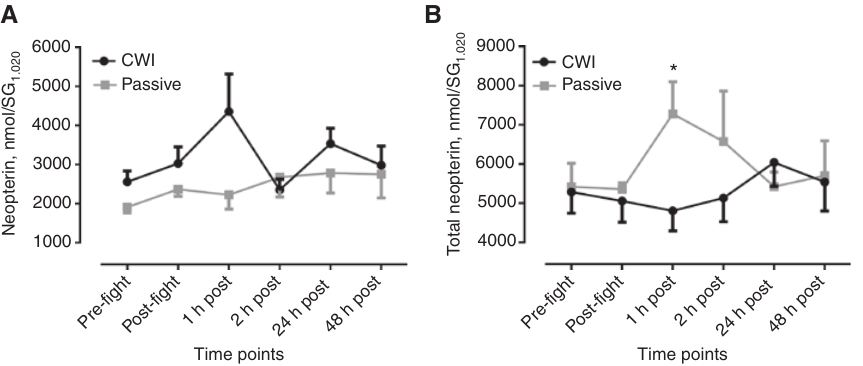
Figure 2: The effect of CWI and passive recovery on changes in urinary neopterin (A) and total neopterin (B). Data are presented as the mean ± SEM. *p < 0.05.